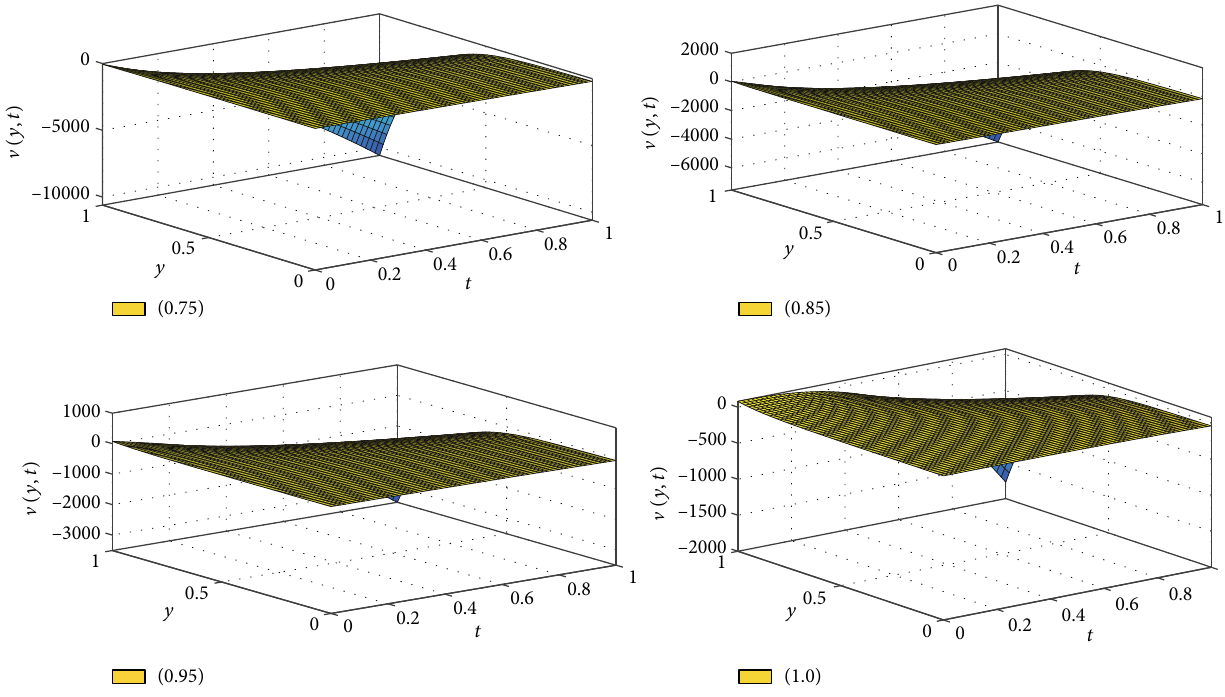
Figure 5: Surface plots of the resultant solution up to four terms at di ff erent values of γ for Example